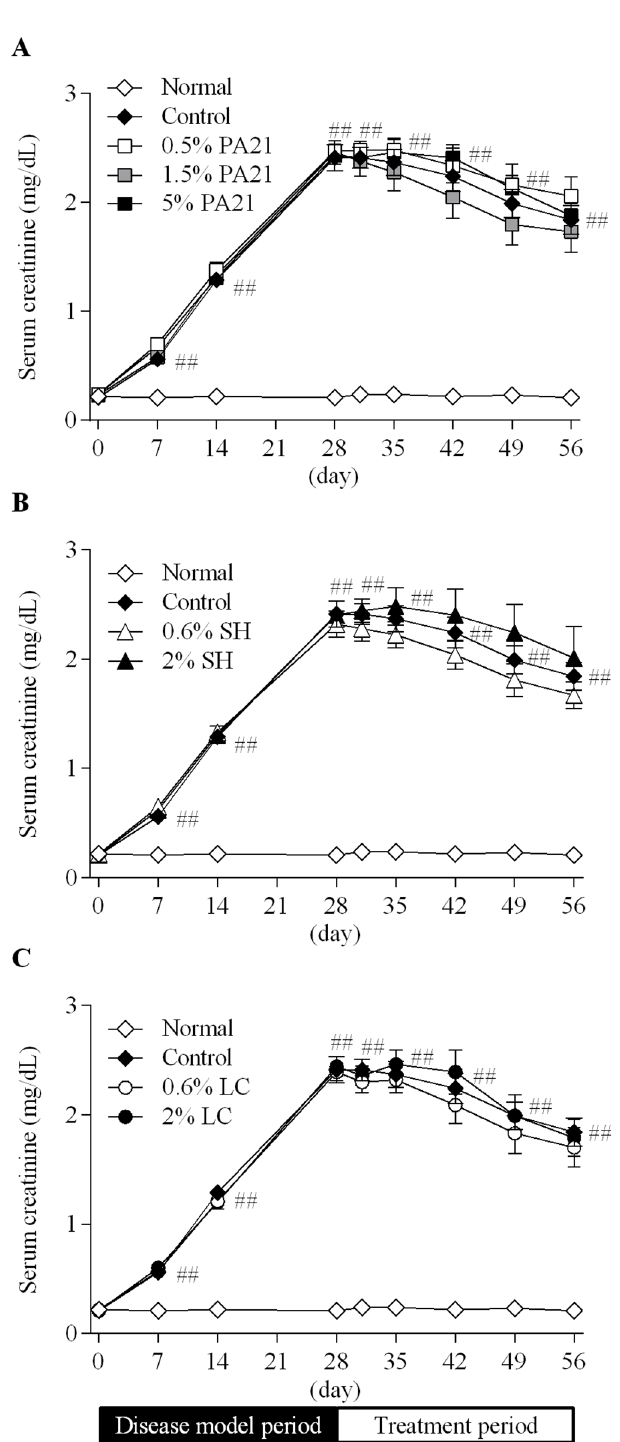
Fig 1. The effects of (A) PA21, (B) sevelamer hydrochloride, and (C) lanthanum carbonate hydrate on serum creatinine level. At day 29, administration of the investigateddrugs was started. Each dot in the figures shows the mean value ± standard error of eight to 10 animals. SH, sevelamerhydrochloride; LC, lanthanum carbonate hydrate. ## P < 0.01, Aspin-Welch’s t-test betweenthe normal and control groups.